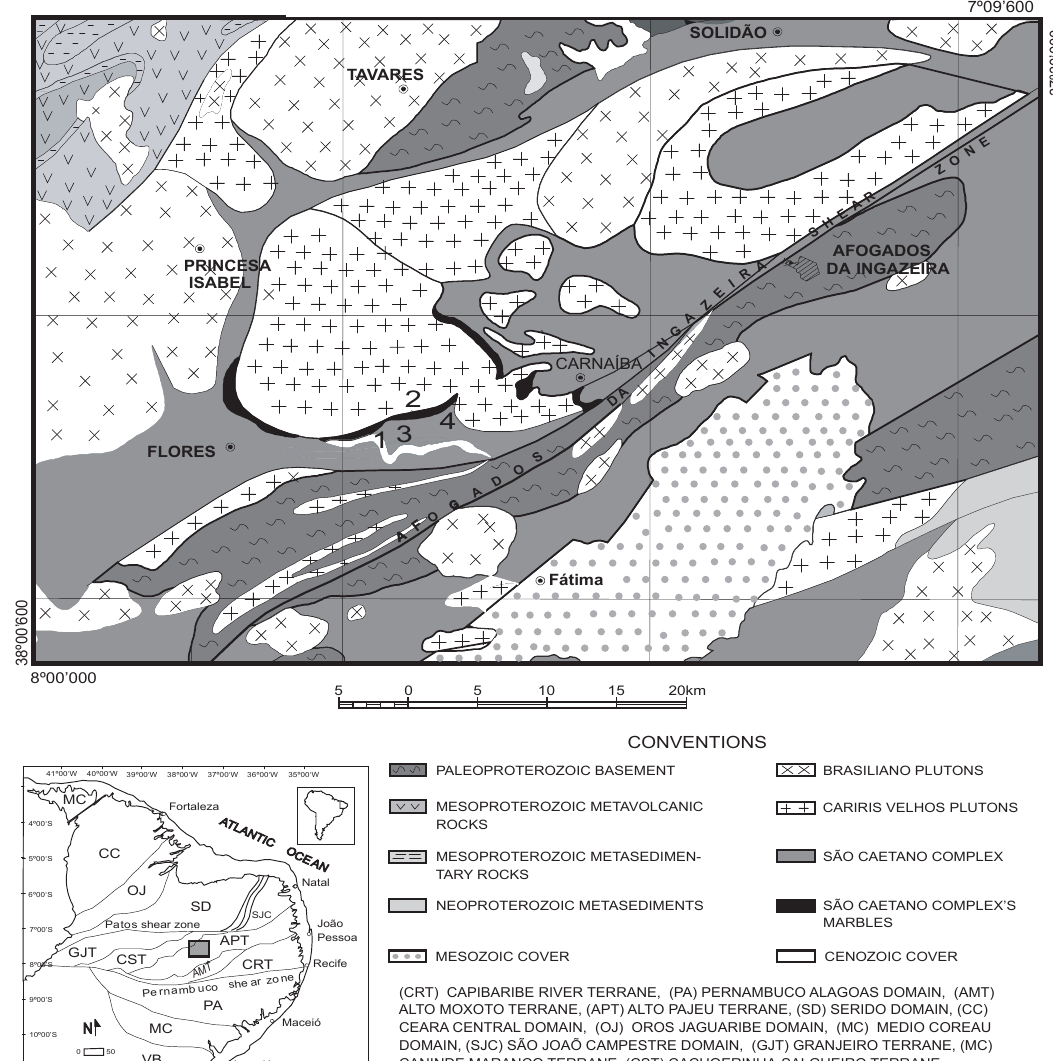
Fig. 1 – Geologic map of the studied area. Numbers represent the location of the stratigraphic sections: 1. Pedra de Cal, 2. Santa Rosa, 3. Malutagem, 4. Rodiador. Tectonic terranes map are from Ferreira et al. (1998). Geologic map modified from Gomes